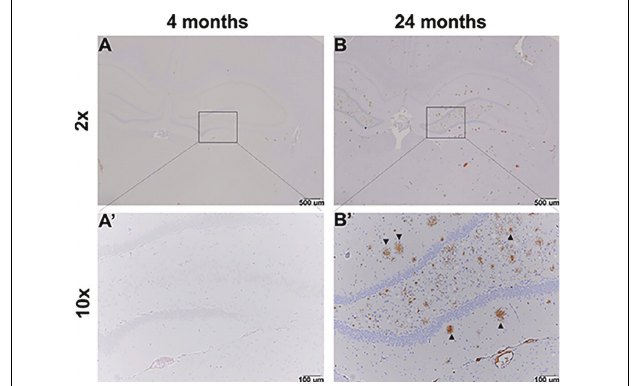
FIGURE 5 | Representative immunohistochemistry images of amyloid- β in the hippocampus of TgF344-AD animals. Amyloid- β positive plaques are not evident in images from a 4-month-old rat (A,A’) . Whereas amyloid- β positive plaques are visible (arrows) in images from a 24-month-old rat (B,B’) .